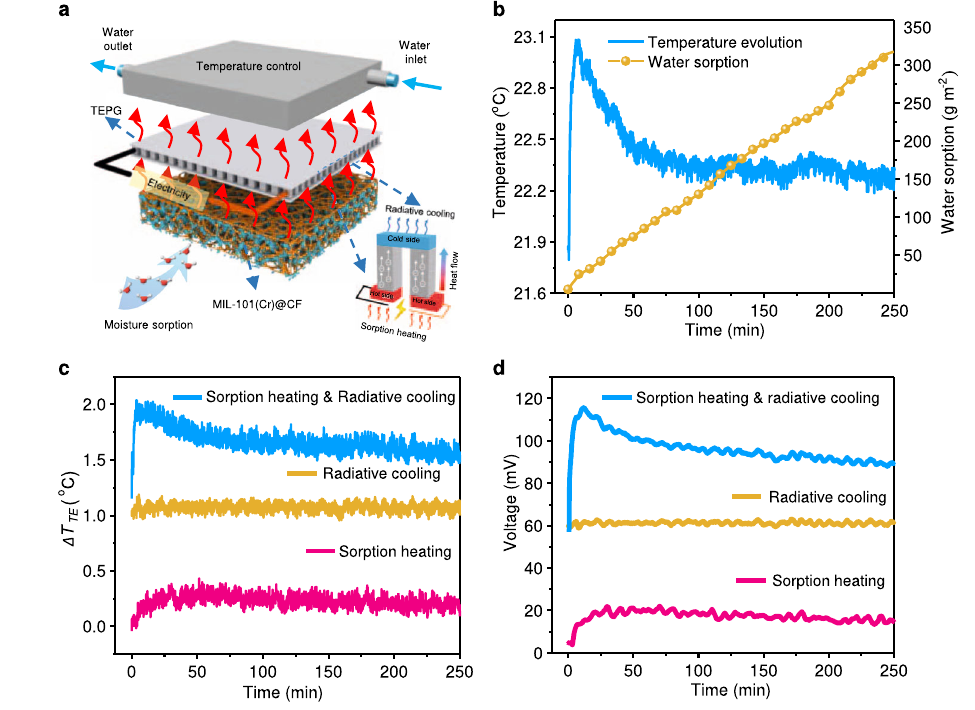
Fig. 3 | Demonstration of synergistic effect of hybrid SAWH-TEPG device in nighttime. Allexperimentswereconductedatatypicalambientconditionof25°C and 65% RH. a Schematic diagram of hybrid SAWH-TEPG device with MIL-101(Cr) @CF using a simulated radiative cooling source. b Temperature evolution and water sorption of MIL-101(Cr)@CF in the hybrid SAWH-TEPG device during